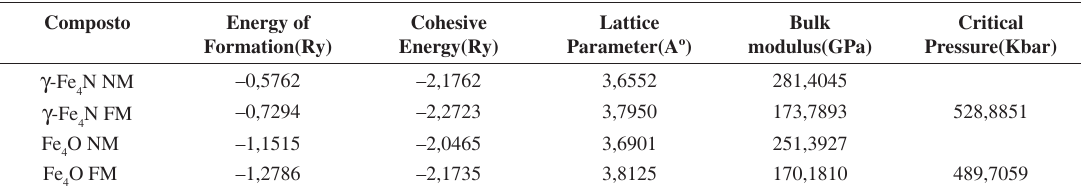
Table 1. Parameters calculated Energy of formation in (Ry), Balance volume in (bhor 3 ), Cohesive energy (Ry), Lattice parameter (bohr).